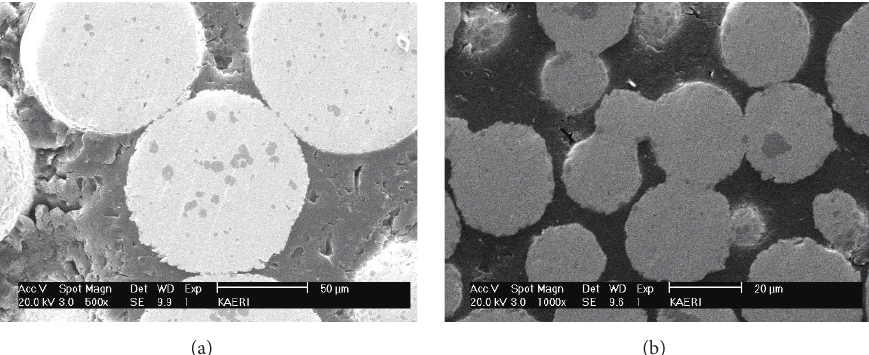
Figure 4: Scanning electron micrographs of U-10wt%Zr alloy particles after sintering at 1100 ∘ C for 1 h: (a) sample C (70 ∼ 100 mesh) and (b) sample E ( − 325 mesh).